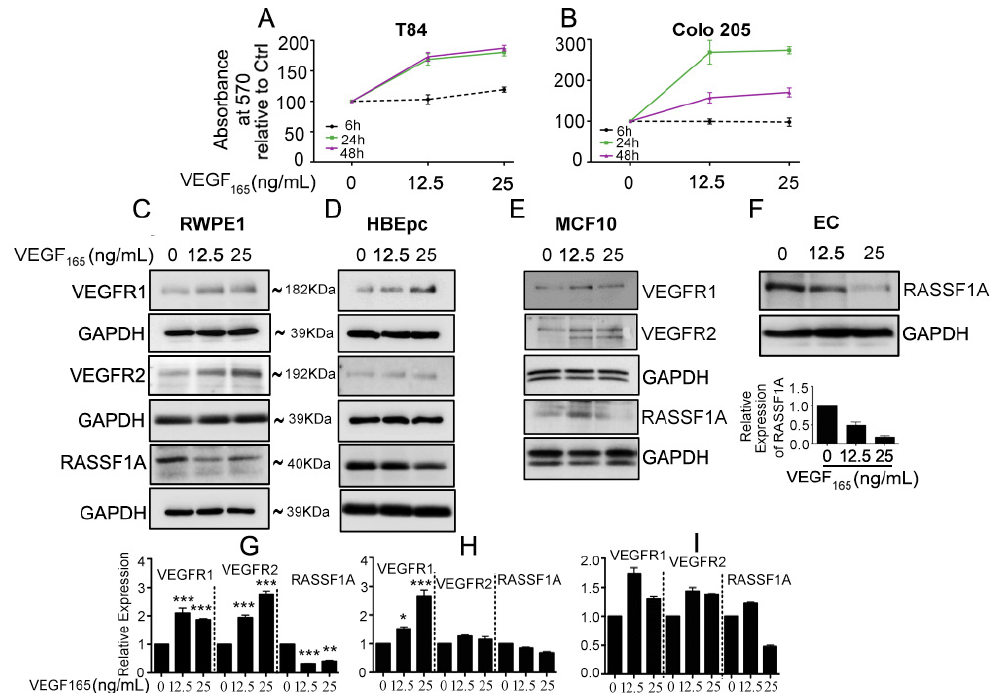
Figure 1. Exogenous VEGF 165 suppresses RASSF1A expression in normal epithelial and endothelial cells. Metastatic colon cancer cells (mCRC, ( A ) T84 and ( B ) Colo 205) were stimulated with VEGF 165 as indicated before and cell metabolism was performed by MTT assay for 6 h (black dash), 24 h (green) and 48 h (pink). Immortalized benign protate (( C ) RWPE1), human bronchial epithelial cells (( D ) HBEpc), immortalized human breast epithelial cells (( E ) MCF-10A), endothelial cells ( F , EC) were stimulated with or without VEGF 165 (12.5 and 25 ng/mL) for 24 h. Cell lysates were monitored by Western blot for p-VEGFR1, p-VEGFR2, RASSF1A, and GAPDH as indicated. Immunoblot was quantified by scanning densitometry and normalized against GAPDH expression for RWPE1 ( G ), HBEpc ( H ), MCF 10A ( I ) and EC (lower panel of ( F )). Results are from three independent experiments and statistical significance was determined using one way-ANOVA followed Bonferroni test. (* p < 0.05, ** p < 0.01, *** p < 0.001).